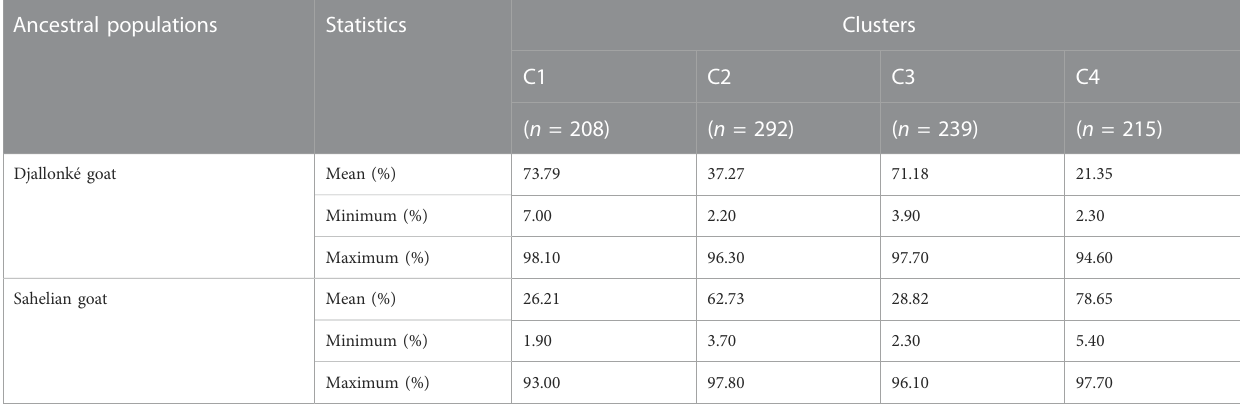
TABLE 5Mean, minimum, andmaximum ofancestralproportions(estimated instructure) for the clusters inferred with the unsupervised clusteringin DAPC inthe sampled goat population ( N = 954). Ancestral populations